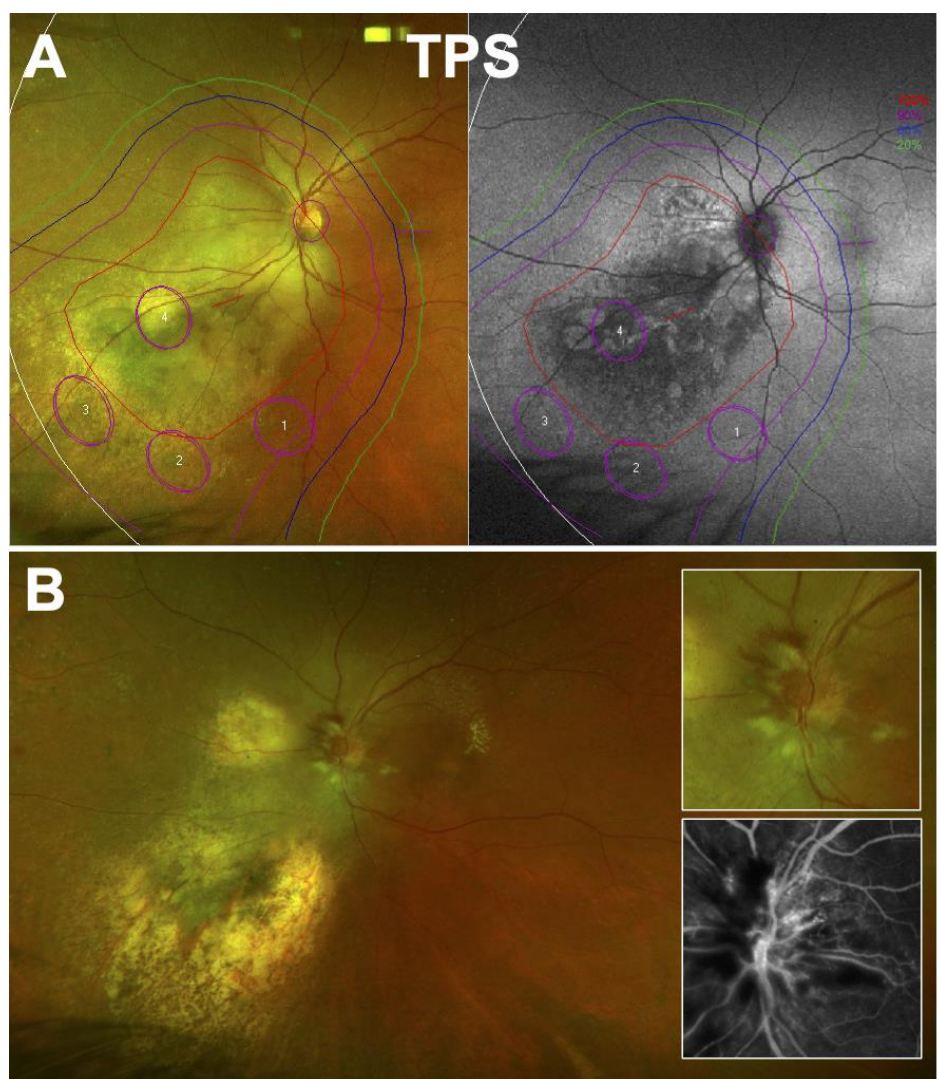
Figure 4. Radiation-induced optic neuritis following proton beam irradiation of a juxtapapillary choroidal melanoma. ( A ) Treatment planning system (TPS) at baseline showing isodoses on fundus autofluorescence and color widefield retinography. Approximately 50% of the optic nerve was planned to receive the full radiation dose. ( B ) At 32 months after irradiation. Observation of optic disc swelling, hemorrhages and cotton wool spots; the tumor site is atrophic. Inset: enlarged view and fluorescein angiography confirming optic nerve edema.